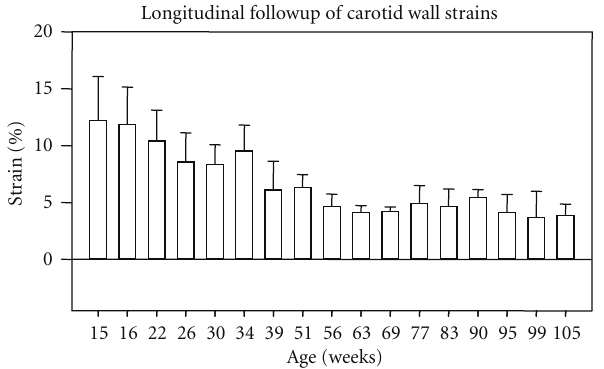
Figure 2: BN’s carotid sti ff ness as a function of aging. Dunnett’s test indicated that the increase in sti ff ness mainly takes place around 40 weeks of age.